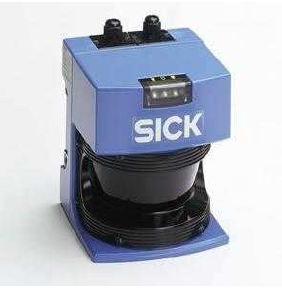
Figure 3. Range laser sensor used in this work.